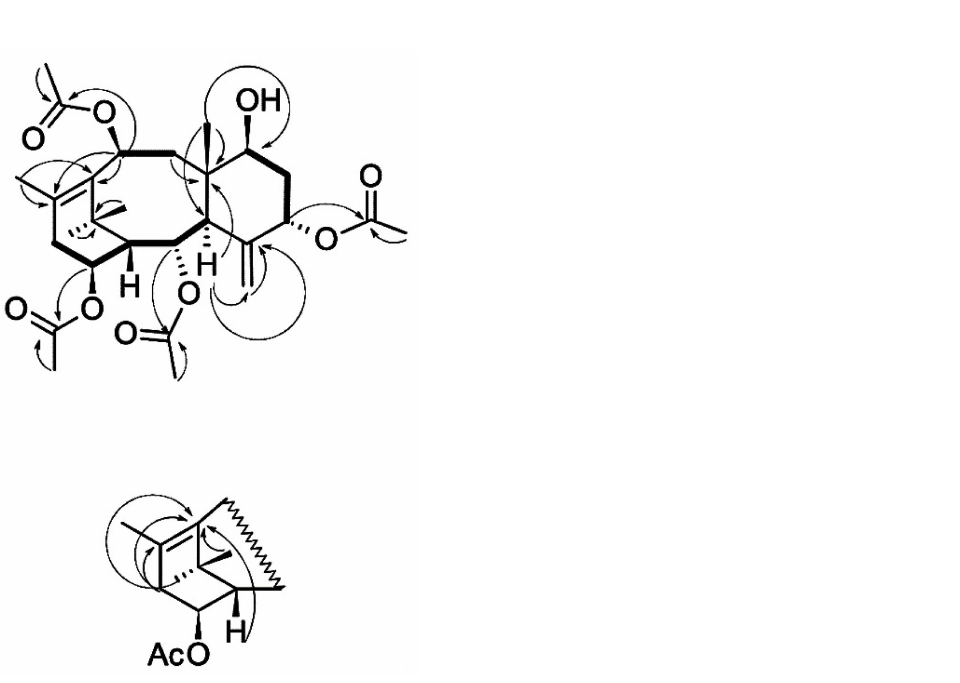
Figure 4. Structure and key 1 H– 1 H COSY (bold lines) and 1 H– 13 C HMBC (arrows) correlations of taxoid I isolated from T. baccata cell suspension